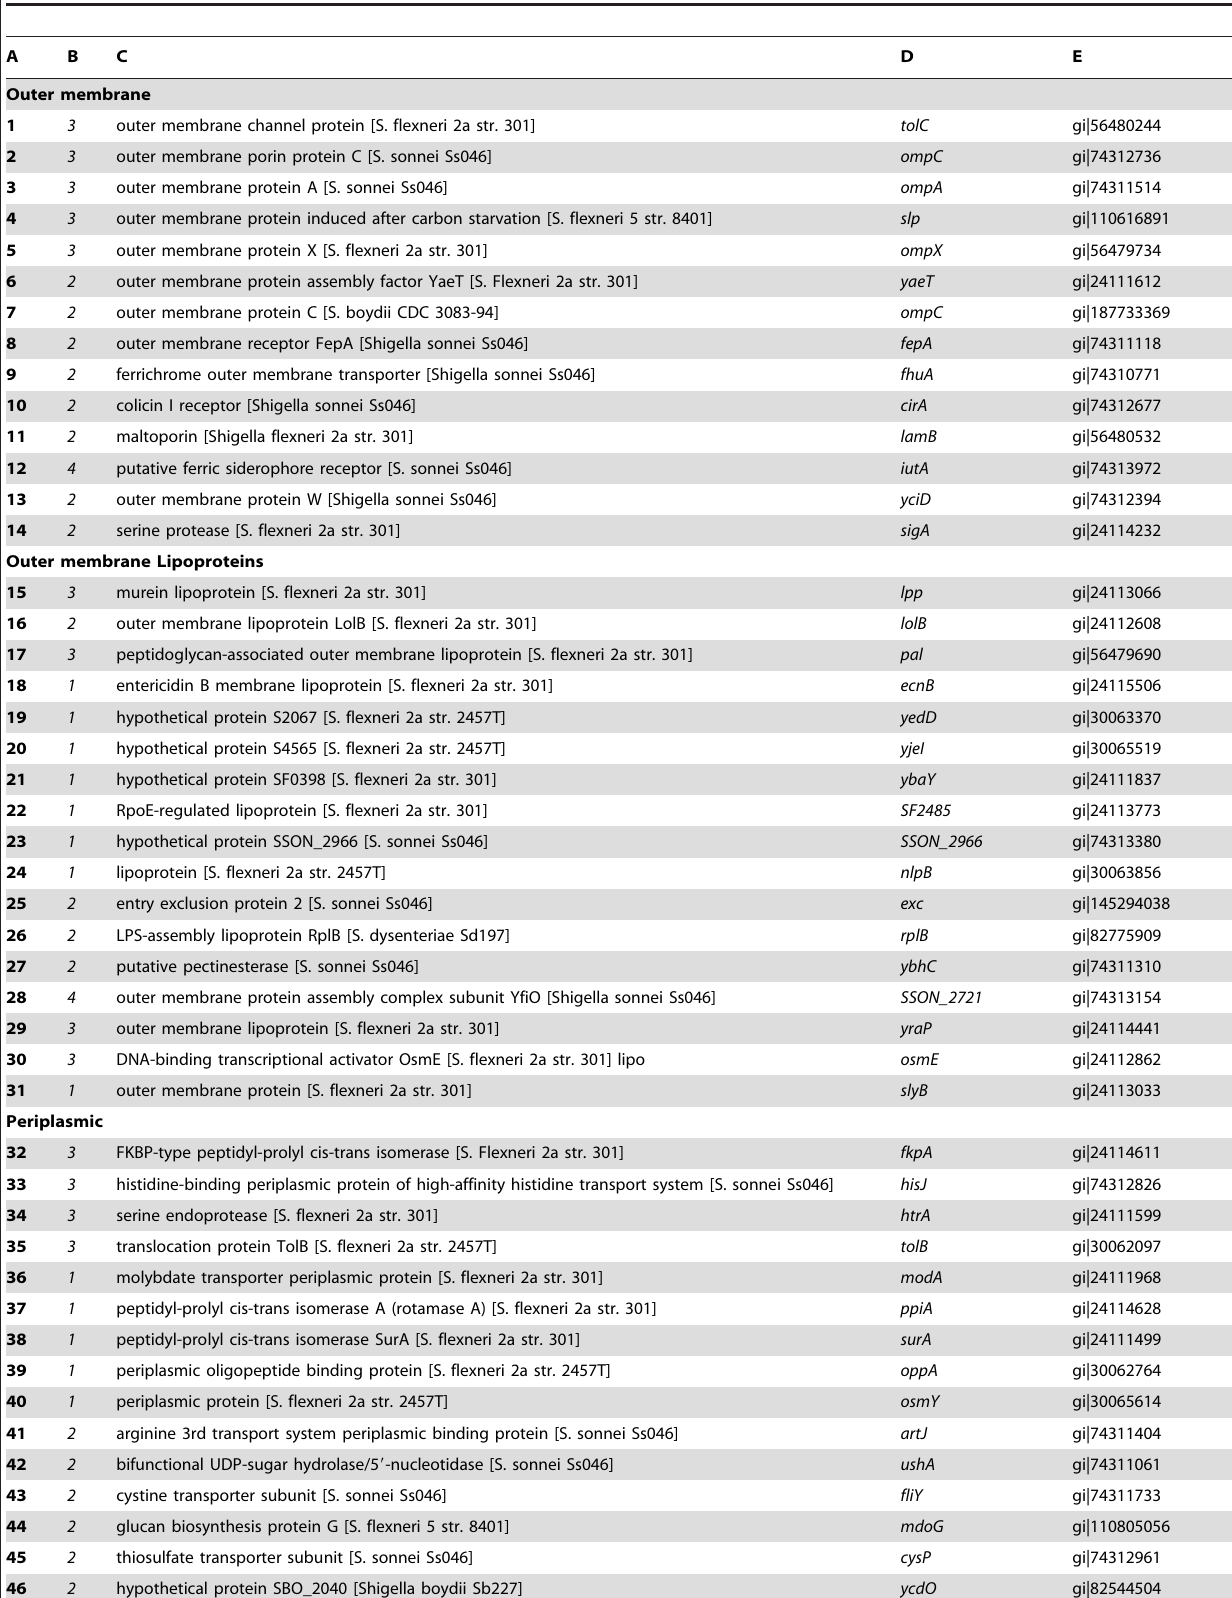
Table 2. Shigella sonnei D tolR D galU GMMA-associated proteins identified by proteomics.